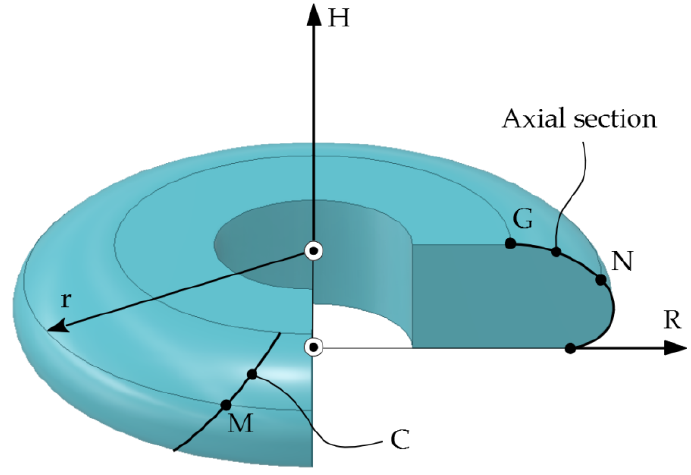
Figure 22. Axial section of the disc tool.